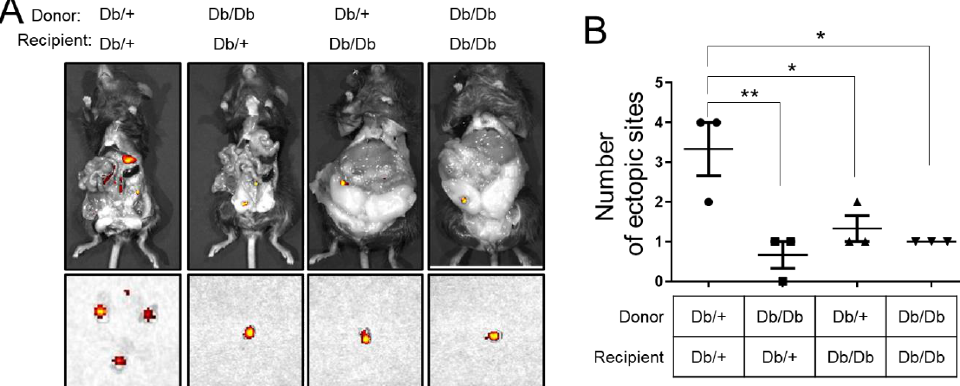
Figure 5. Effects of obesity with leptin receptor deficiency on endometriosis. ( A ) Representative Cy5.5 signaling of db /+ and db / db recipient mice with db /+ and db / db endometriotic lesions. Endometriosis was surgically induced in 8-week-old db /+ or db / db female recipients of donor uterine fragments from control db /+ or db / db uteri labeled with Cy5.5 dye-doped silica nanoparticles. ( B ) Quantification of data for the number of ectopic sites were significantly lower in different donor and recipient condition compared with heterozygous donor and heterozygous recipient. Data are represented as mean ± SEM. * p < 0.05 and ** p < 0.01.